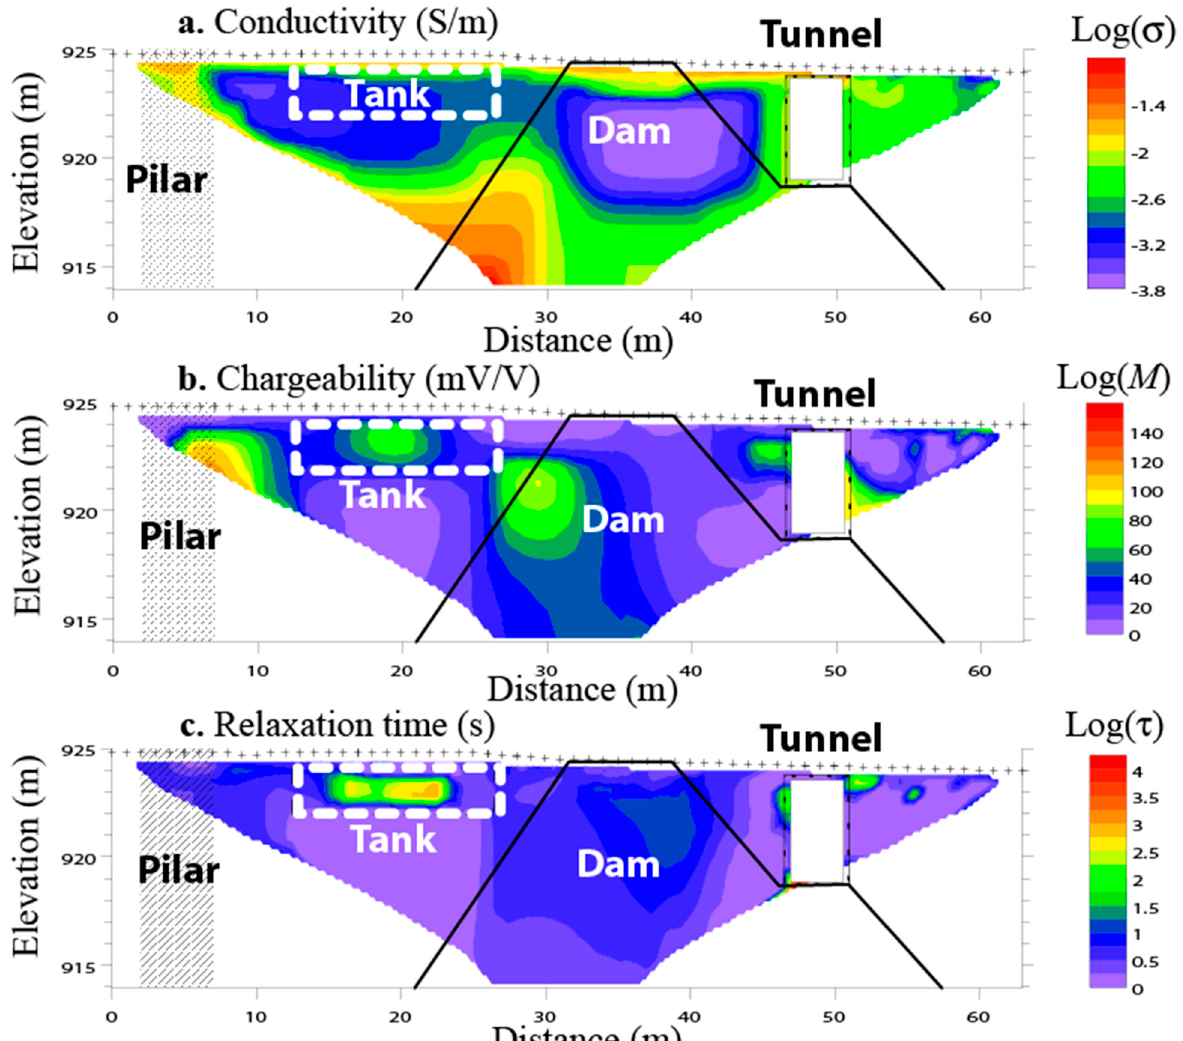
Figure 32. Tomography of a dam with the position of a metallic tank underground. ( a ) Tomography of the electrical conductivity. ( b ) Tomography of the chargeability. ( c ) Tomography of the relaxation time (in s). Note how the tomography of the relaxation time can be used to assess the position of the metallic tank with a precision that is better than using chargeability tomography. Unpublished